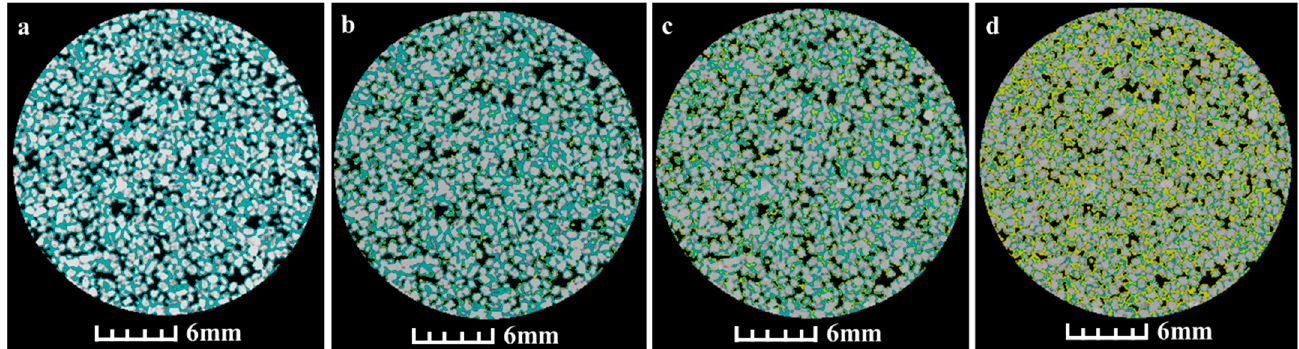
Figure 8. Variation of acoustic wave velocity with hydrate saturation during hydrate formation.